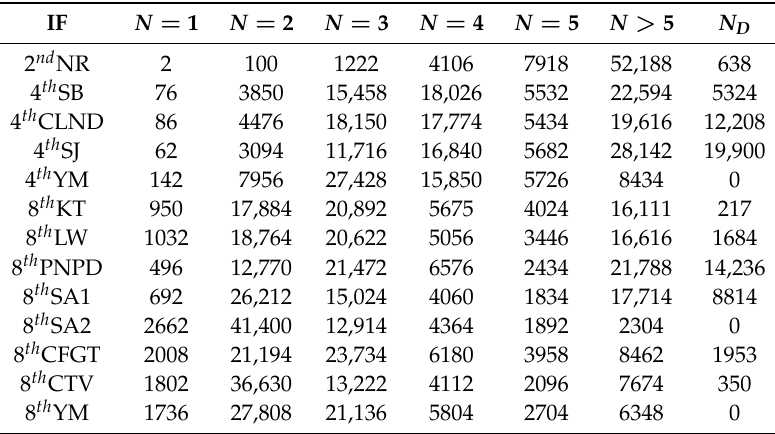
Table 10. Results of the polynomials p 3 ( z ) = z 5 −